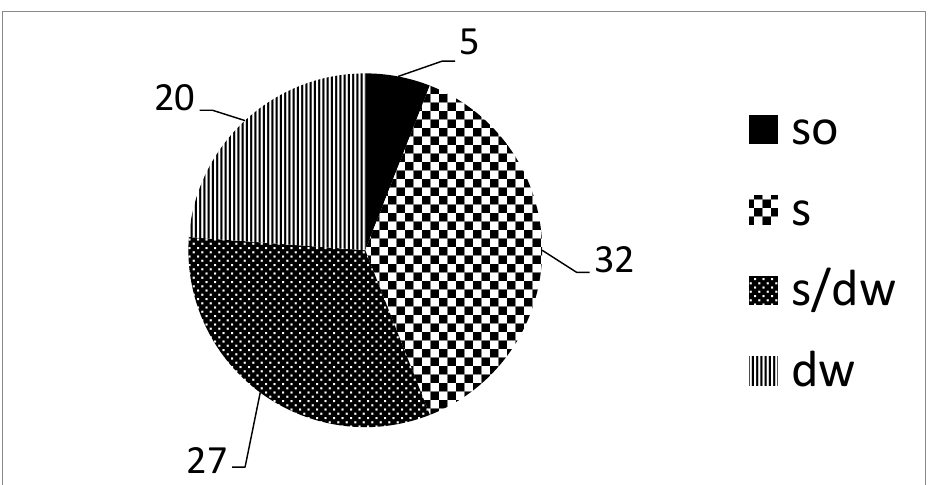
Figure 1. Number of species with different habitat preferences in all examined locations: SO— species found only in soil, S—species found in soil, S/DW—species found in soil and dead wood, DW—species found only in dead wood and tree hollows.